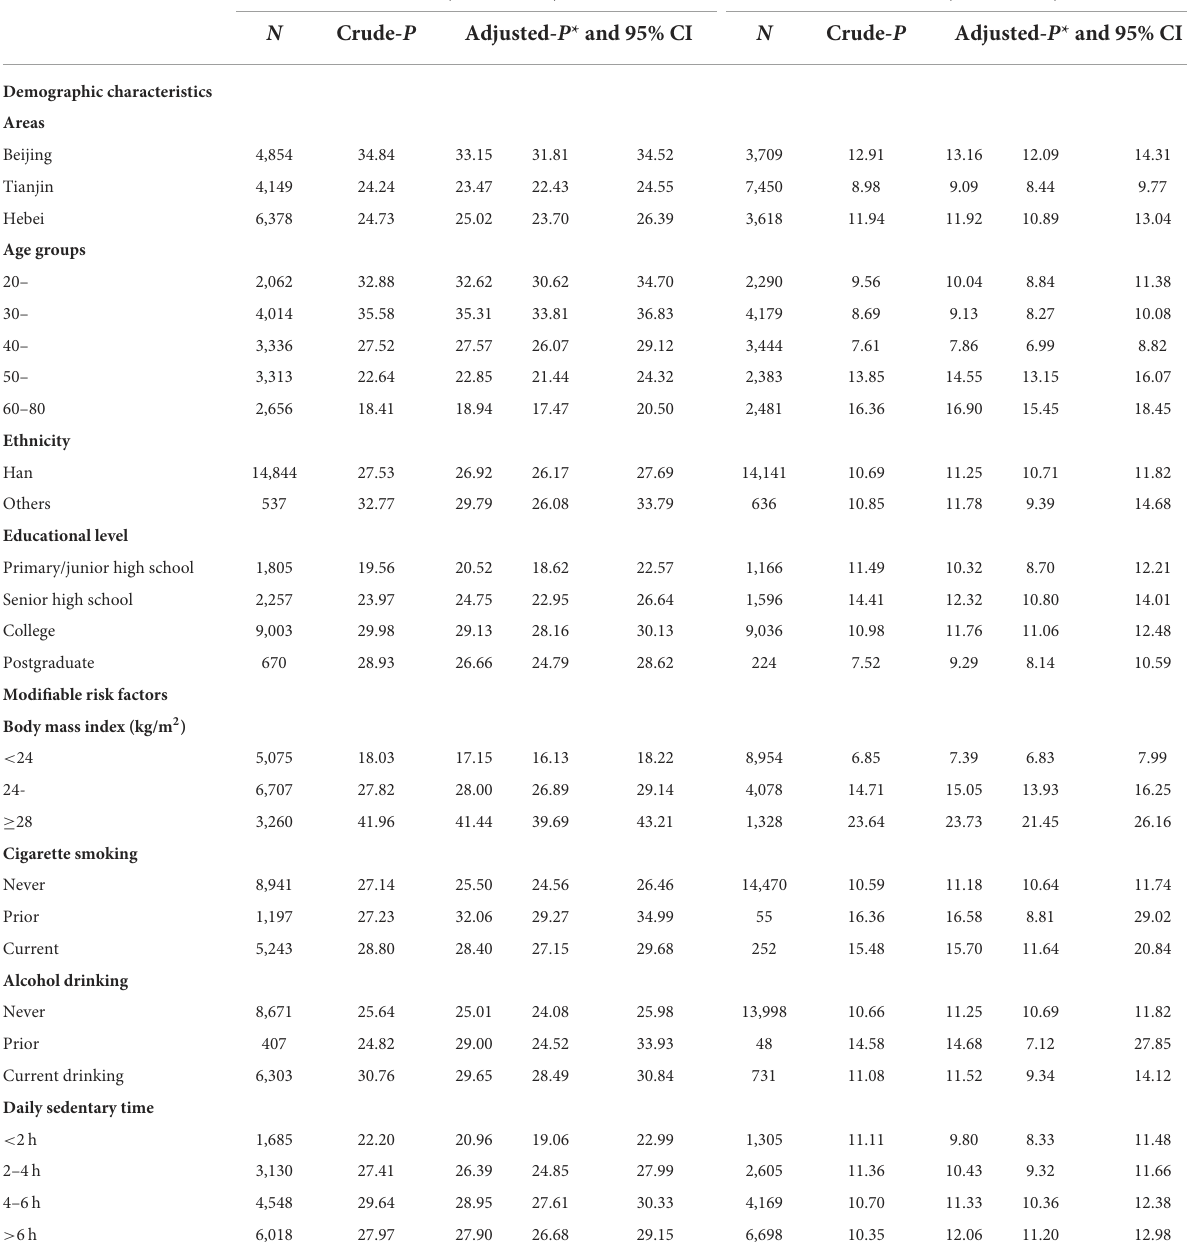
TABLE 1 The prevalence of hyperuricemia in general population from the Beijing, Tianjin, and Hebei areas ( n = 30,158). Male ( n = 15,381) Female ( n = 14,777) N Crude- P Adjusted- P * and 95% CI N Crude- P Adjusted- P * and 95%